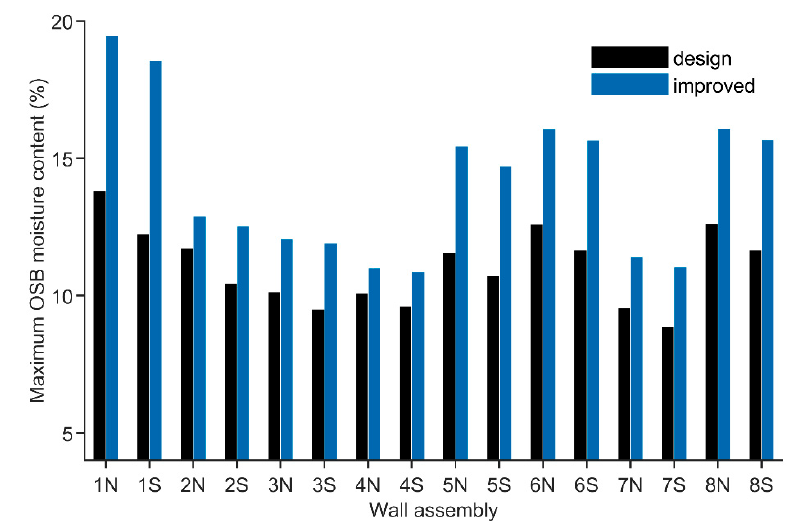
Figure 9. Maximum OSB MC for all walls, comparing design with improved model.